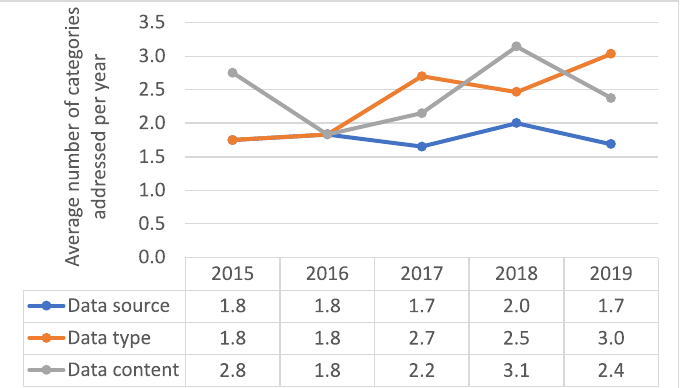
Figure 10. Average number of data source/data type/data content categories per